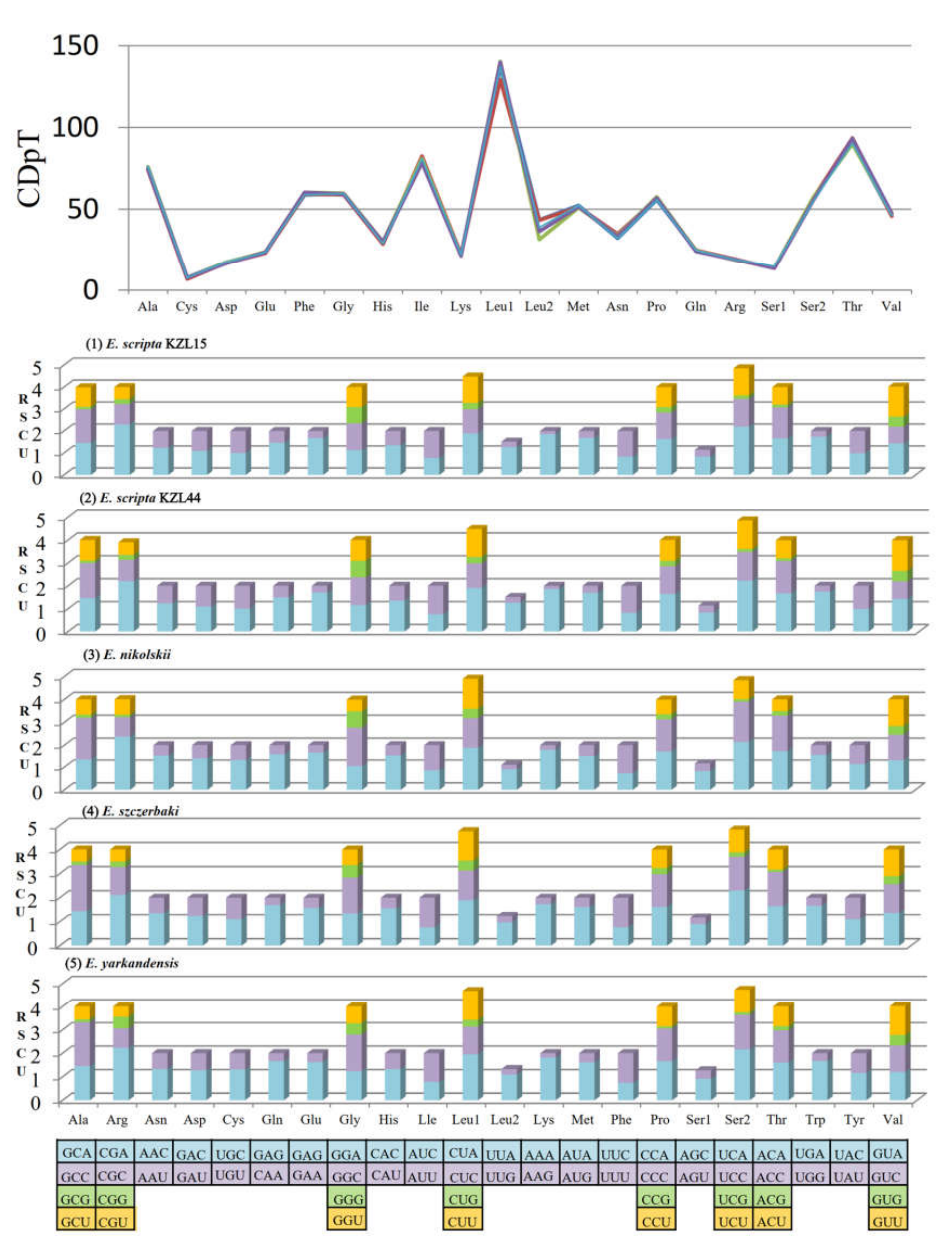
Figure 2. The base composition and the relative synonymous codon usage (RSCU) values of E. scripta KZL15, E. scripta KZL44, E. nikolskii , E. szczerbaki , and E. yarkandensis , respectively. CDpT stands for codons per thousand codons. The color of blue, purple, green and yellow means the first, second, third and fourth type of each amino acid.